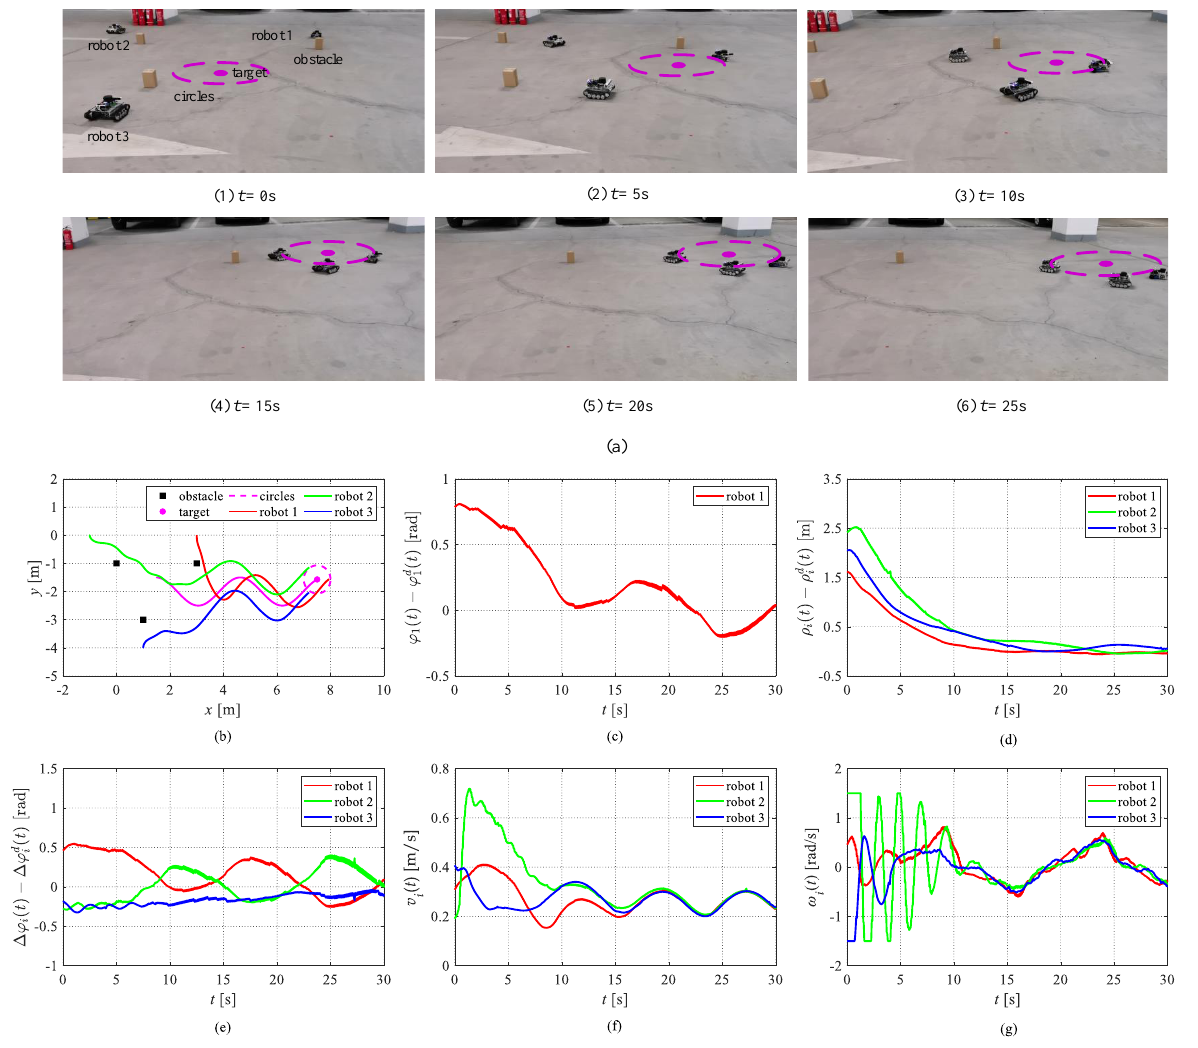
Figure 9. Experimental results of case 3. ( a ) The motion views of three nonholonomic mobile robots forming a evenly distributed circular formation with same circular radius to enclose and track a moving target with time-varying speed. ( b ) Trajectories of the three robots and the target in the plane. ( c ) Error between current phase and the desired phase of robot 1. ( d ) Distance errors between the three robots and their desired circles centered on the target. ( e ) Errors between current angular spacing and the desired angular spacing of all adjacent inter-robots. ( f ) The linear speeds of the three robots. ( g ) The angular speeds of the three